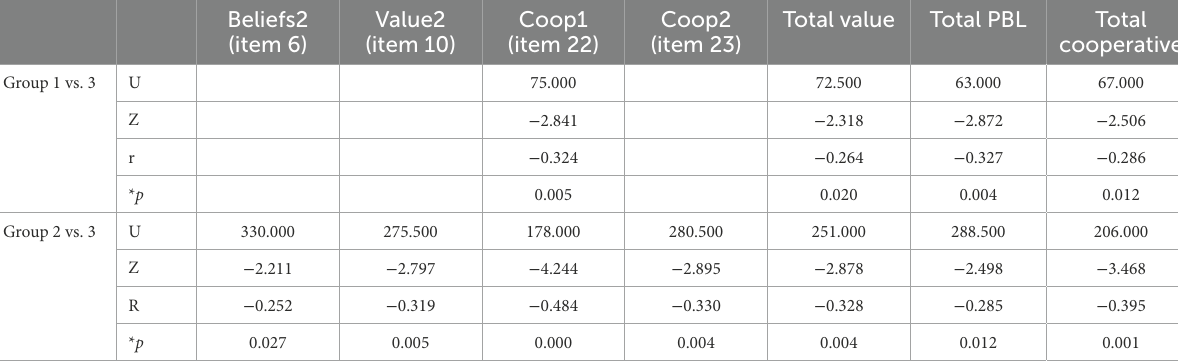
TABLE 6 Post-hoc Mann–Whitney U -test analysis to evaluate how motivation depends on